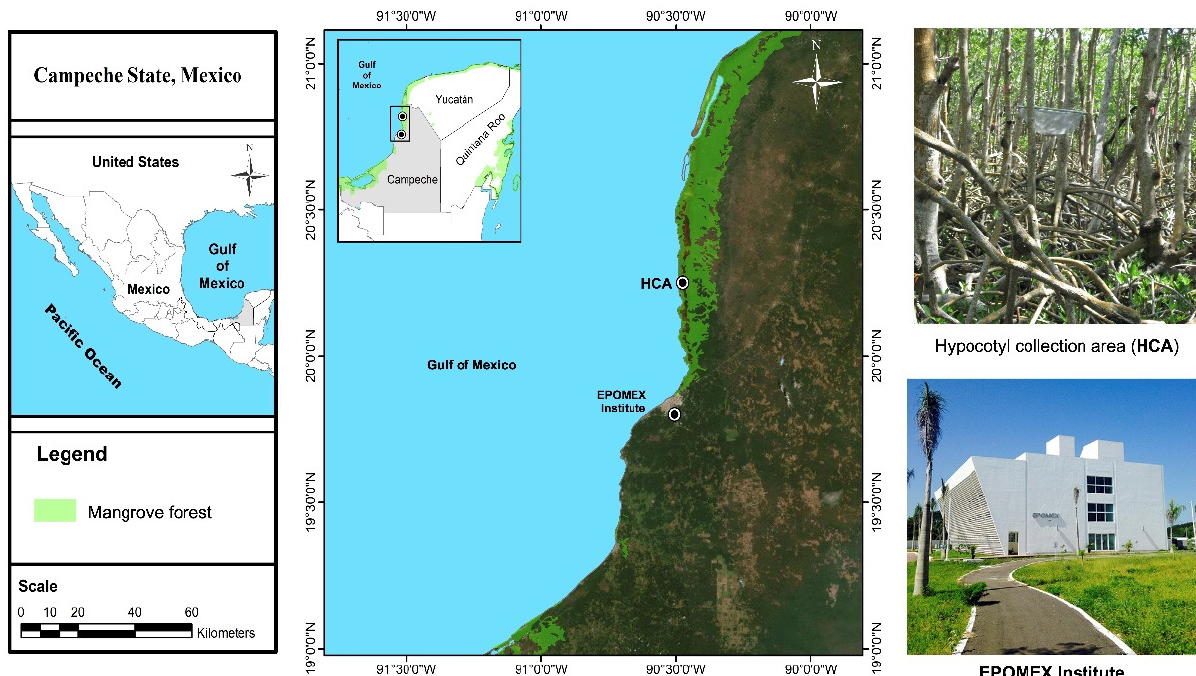
Figure 1. Geographic location of the Rhizophora mangle hypocotyl collection forest in the Los Petenes Biosphere Reserve (RBLP), Campeche, Mexico, and development sites of the experiment (EPOMEX Institute).